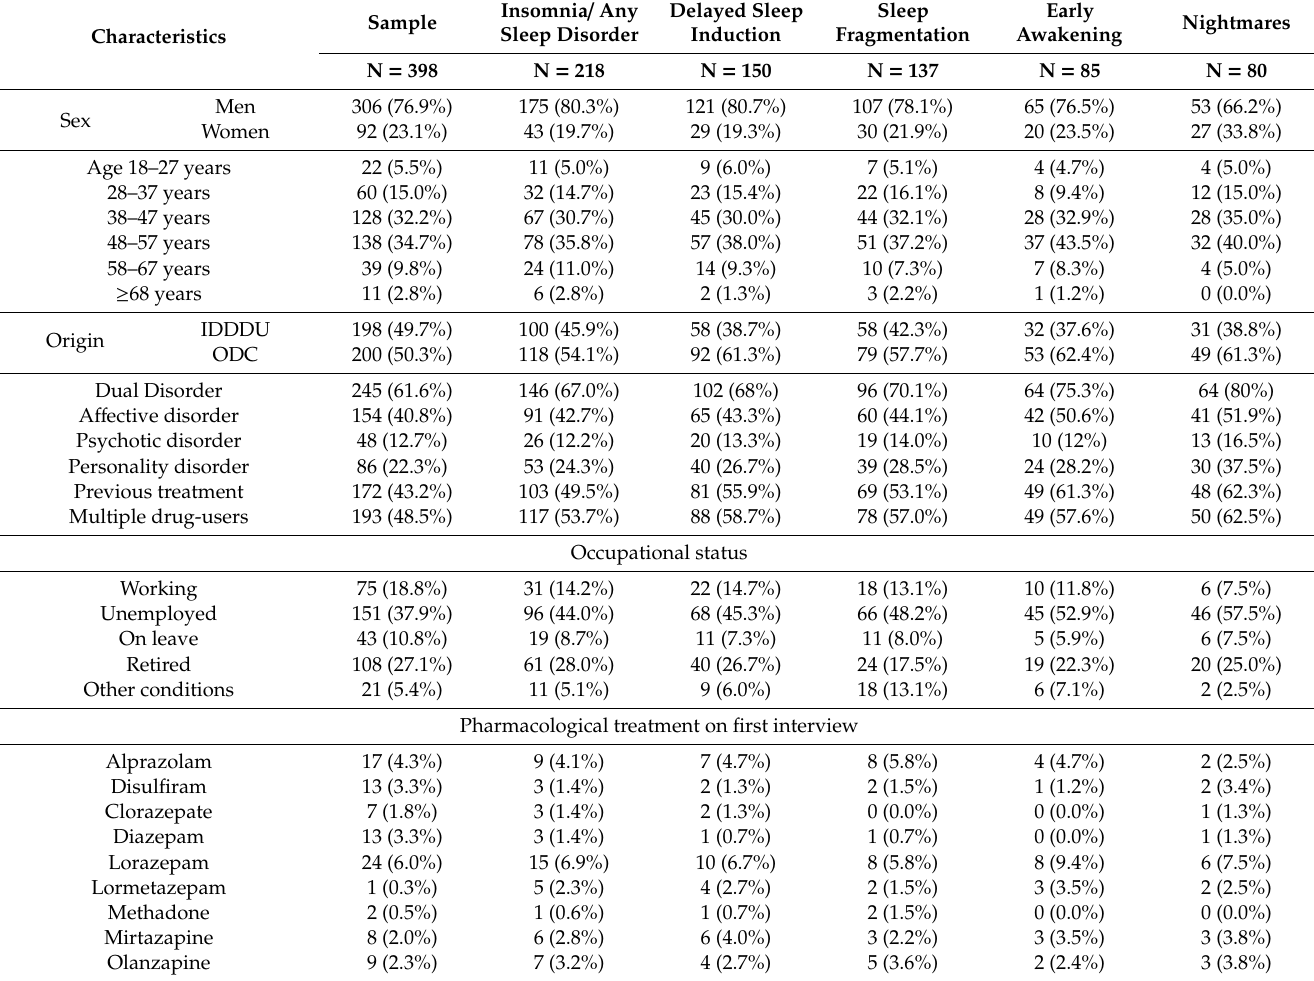
Table 1. Descriptive representation of demographic, clinical, and psychiatric variables in each sleep disorder and in the total sample. N and percentages are represented for each variable. Abbreviations: IDDDU: Inpatient Dual Diagnoses Detoxification Unit; ODC: Outpatient Drug